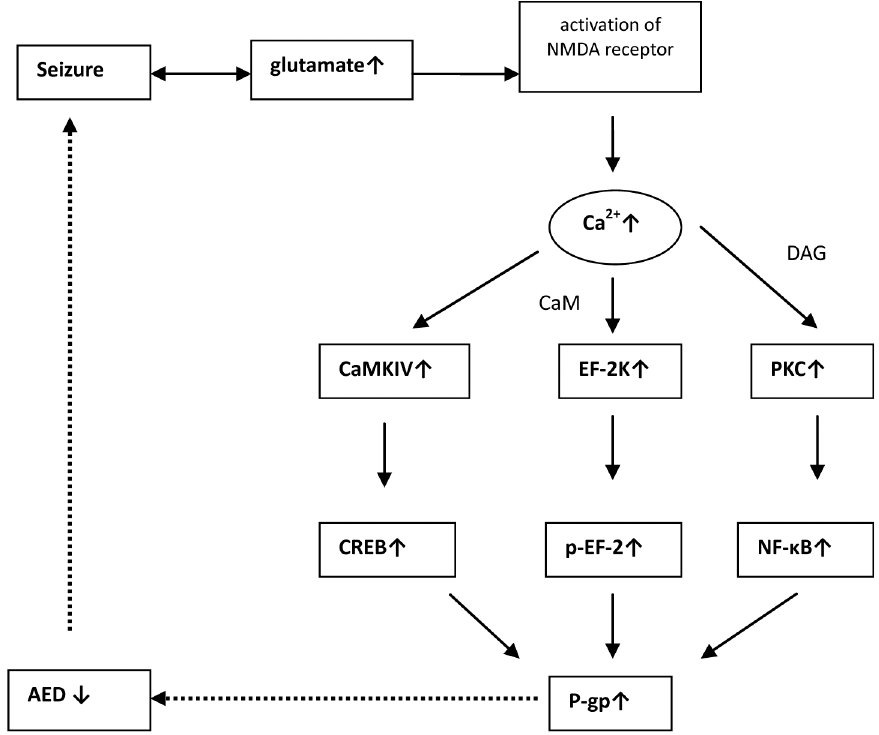
Fig 11. The whole schematic of proposed glutamate-NMDA receptor-P-gp signaling pathways. The other two signal pathways have been reported via increasing P-gp expression and turn to be drug resistant in several kind of